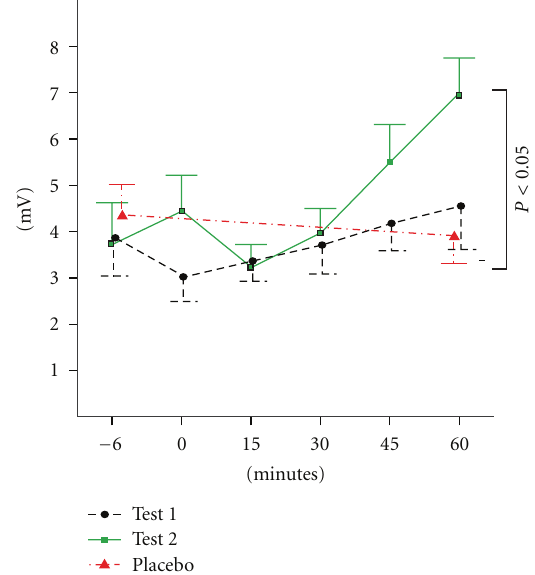
Figure 2: Changes of MEP amplitudes of FDI before and after TMS with MVC under the test 1, test 2, or placebo conditions. Values show means ±